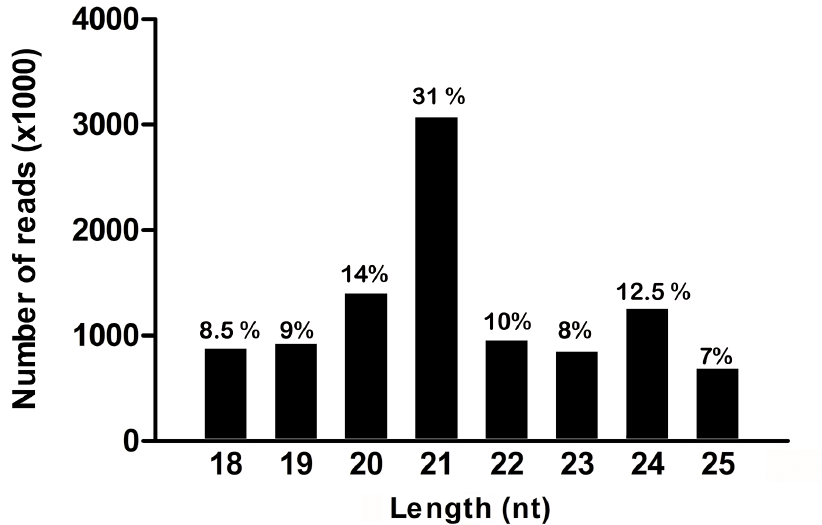
Fig 2. Size distribution of P . minima sRNA sequences. The graph displaysthe raw numberof sRNA reads in the range of 18 to 25 nt. The percentage of reads in each size category in the range is indicated.A large peak at 21 nt and a smaller peak at 24 nt are